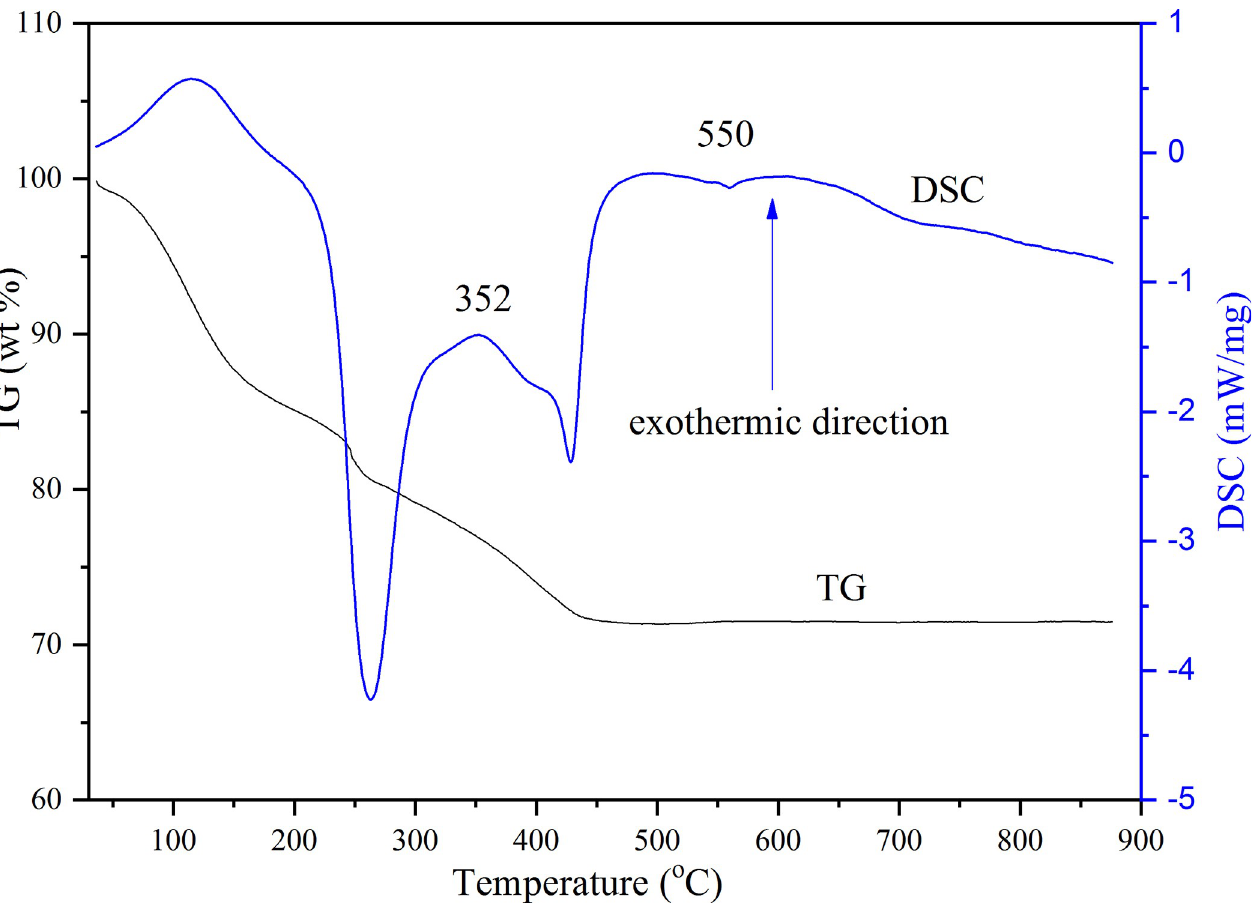
Fig 2. TG-DSC curves of the C/TiO 2